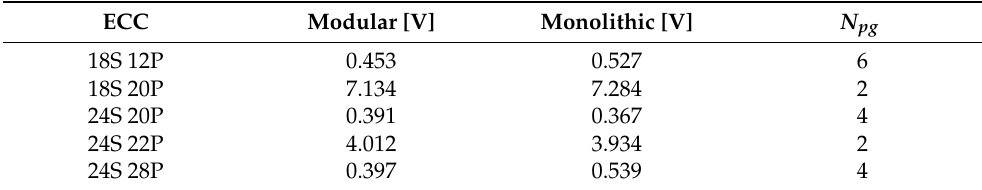
Table 17. Maximum back-emf unbalance for different PMSM and MPMSM slot/pole combinations in the presence of